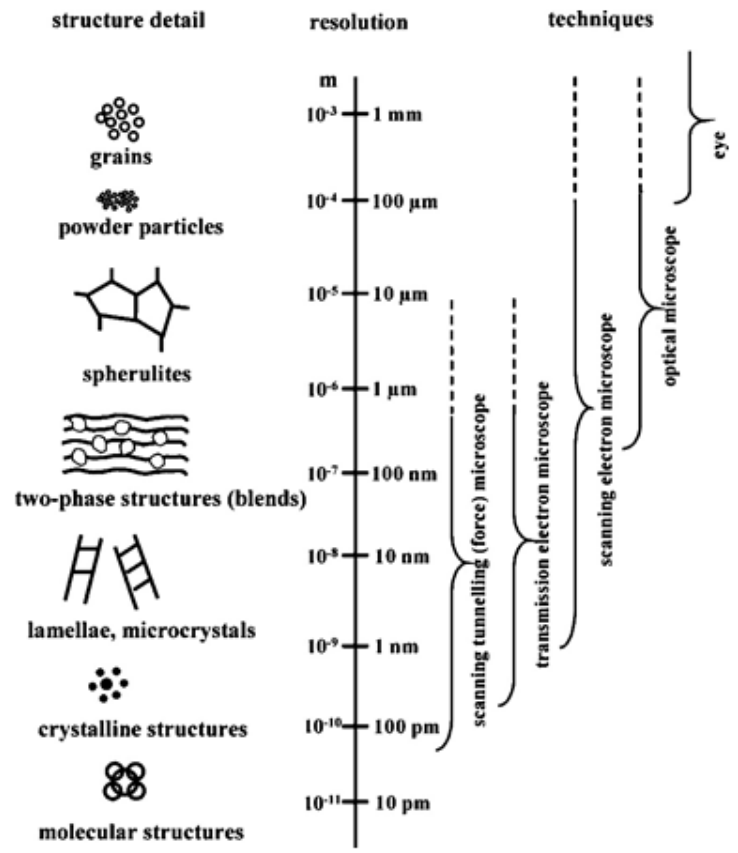
Figure 2. Assorted polymeric structures and the attainable resolutions with various microscopic techniques [64]. (Reprinted with permission from Michler et al., 2008.) Table 1. Summary of various microscopic techniques, their applications and relevant biopolymers illustrated in the current review.